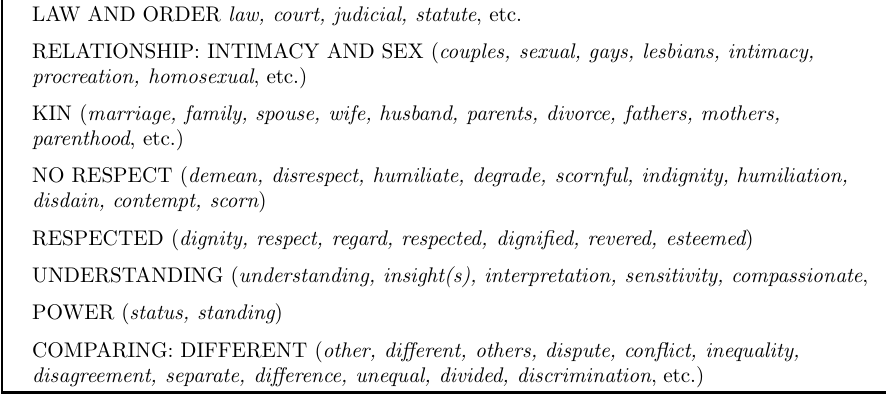
Table 4 Key semantic concepts in majority and dissenting opinions LAW AND ORDER law, court, judicial, statute ,